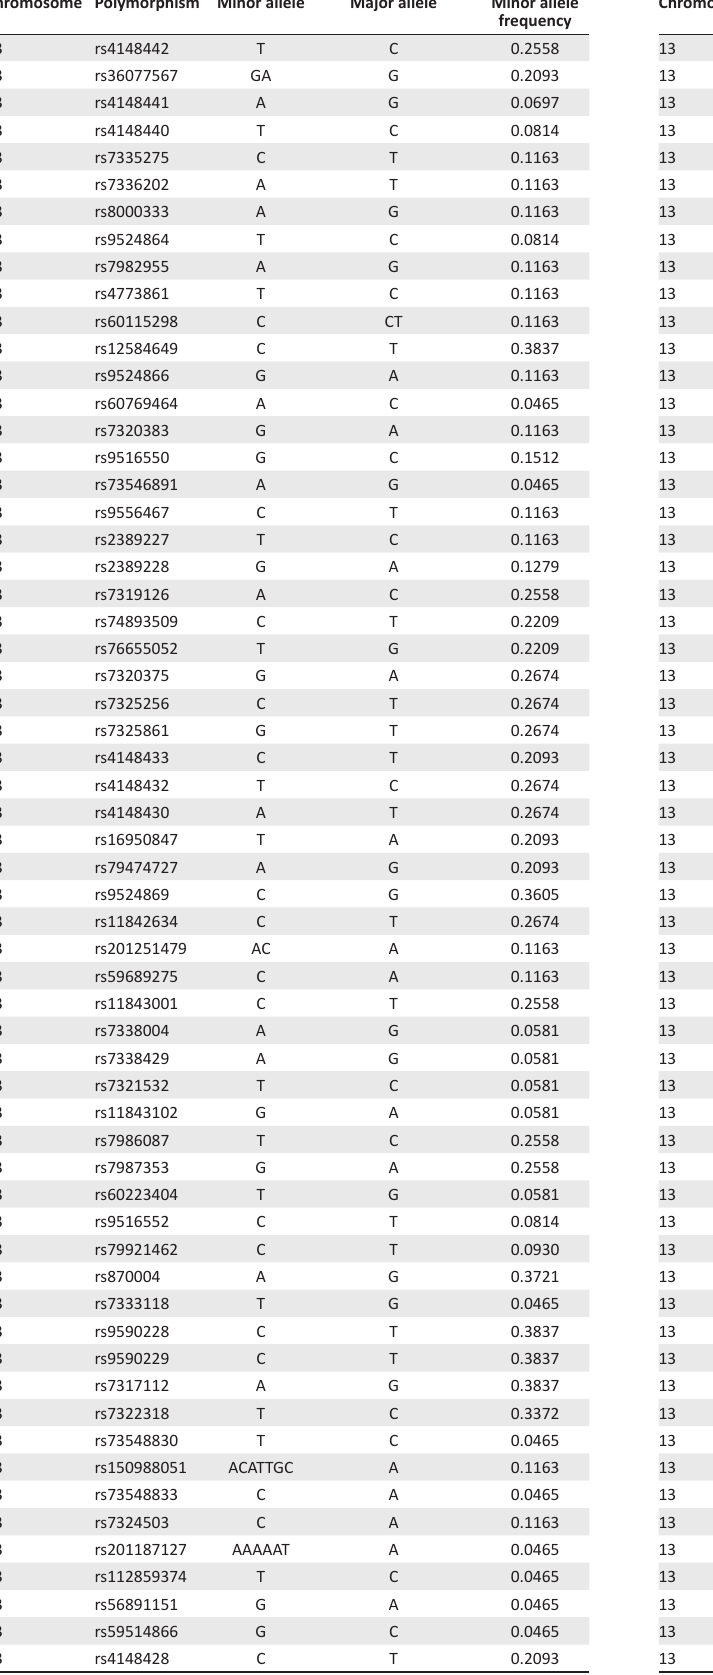
Table 1-A1 continues on the next page →Table 1-A1 continues in the next column